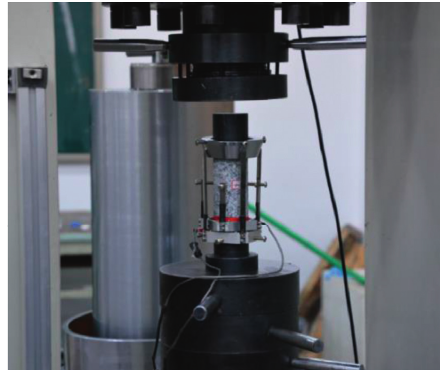
Figure 5: Compressive strength tested.